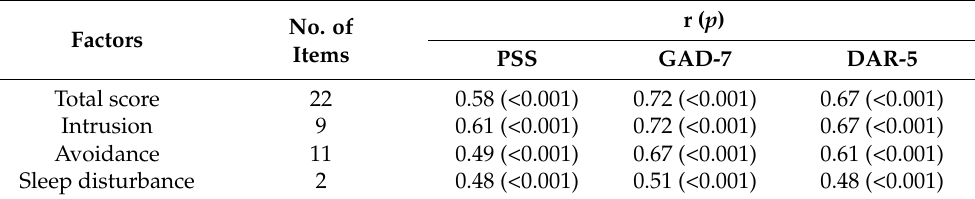
Table 4. Correlation of the IES-R with other variables (N =